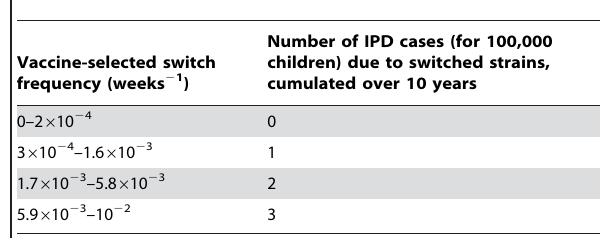
Table 3. IPD cases due to capsular switch. Number of